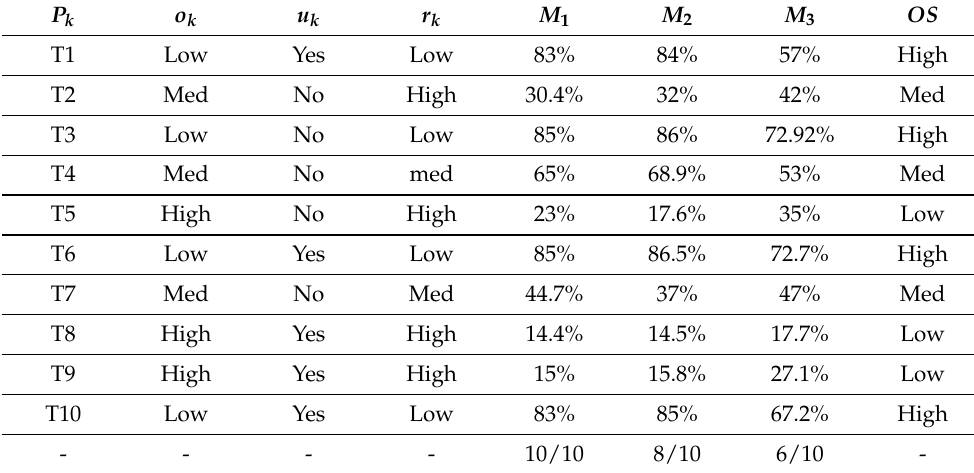
Table 8. The probability of offloading u k for each task T k according to our mechanism compared to the other two